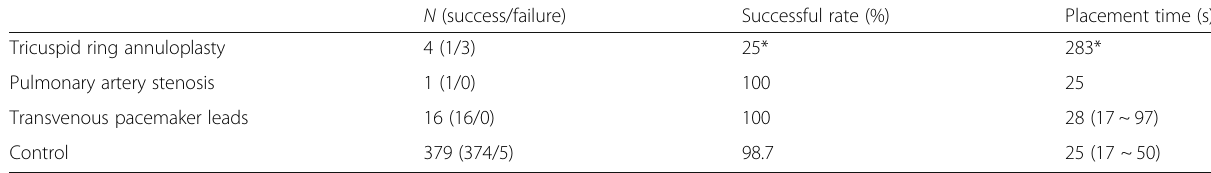
Table 2 Successful rate and the PAC placement time in each category N (success/failure) Successful rate (%) Placement time (s) Tricuspid ring annuloplasty 4 (1/3) 25* 283* Pulmonary artery stenosis 1 (1/0) 100 Transvenous pacemaker leads